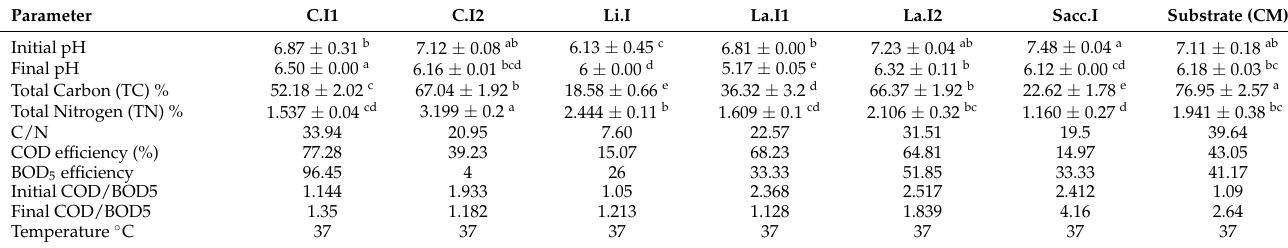
Table 3. Anaerobic digestion parameters monitoring of BMP experiments for CM substrate and with the addition of different